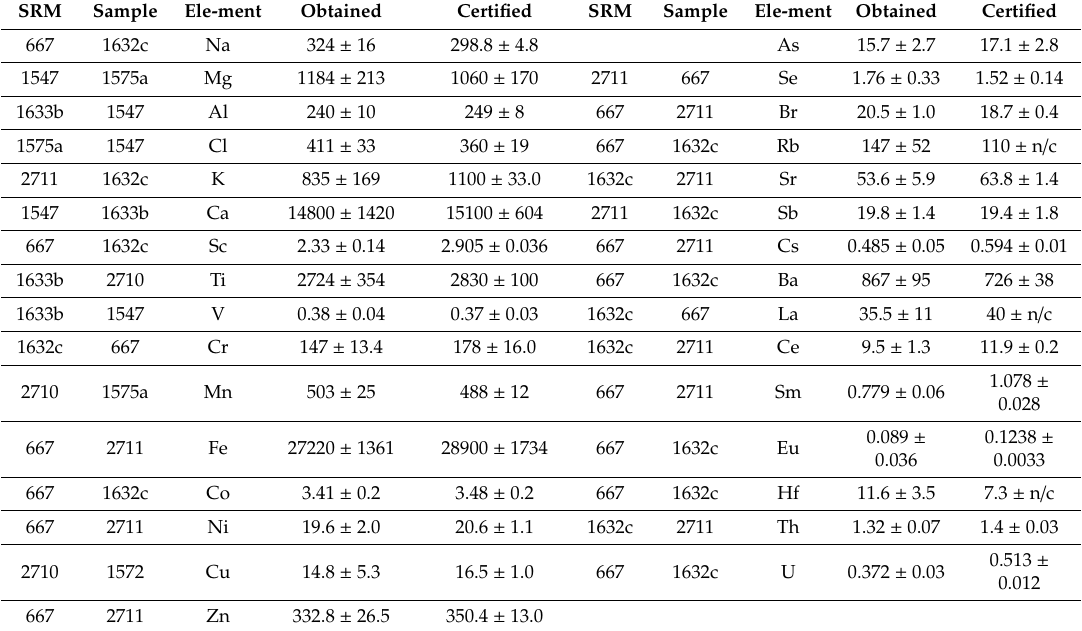
Table 1. Epithermal Neutron Activation Analysis (ENAA)-obtained and certified values of reference materials, mg /